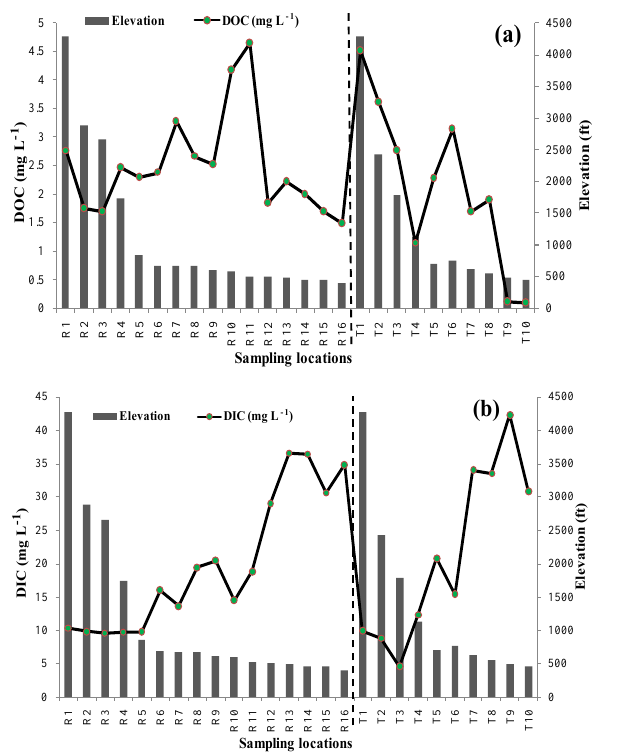
Figure 4. Spatial variation in the DOC and DIC concentration of the Ramganga River and its